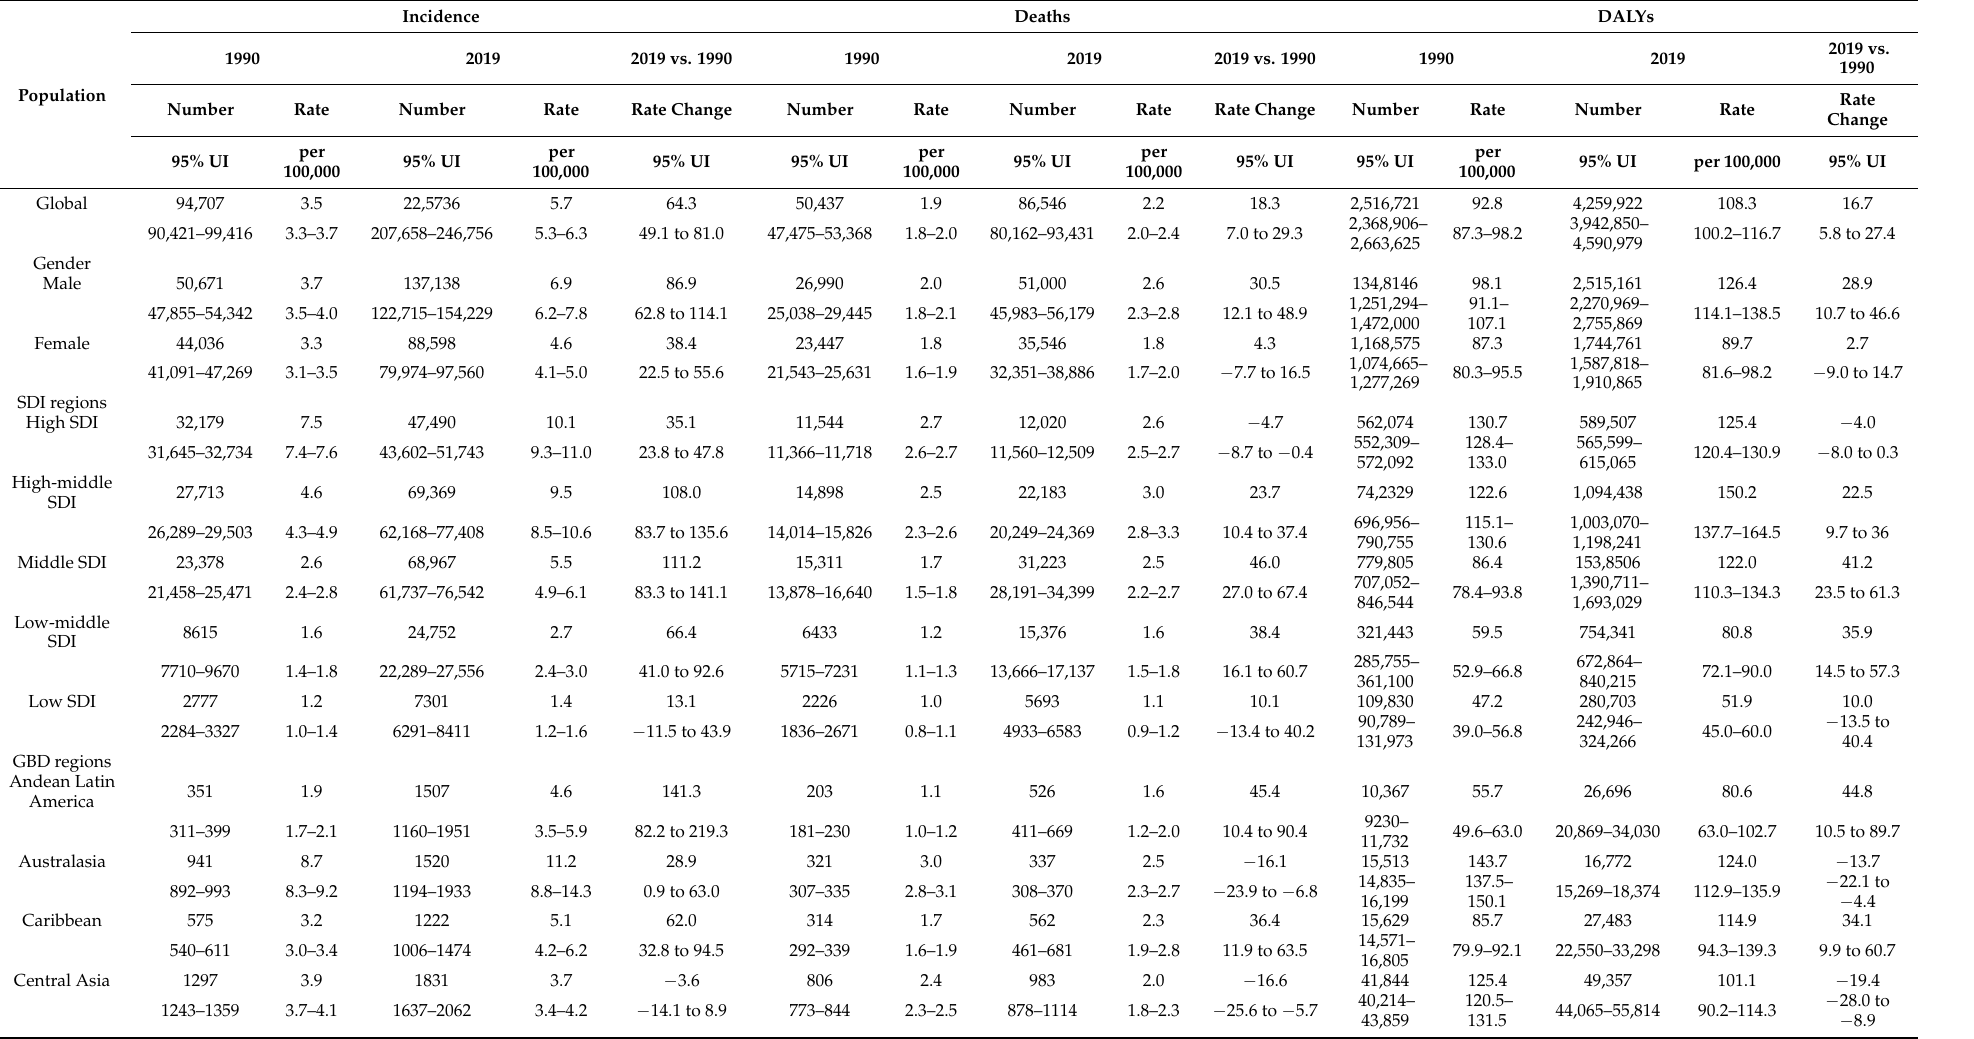
Table 1. Incidence, deaths, and DALYs of early-onset colorectal cancer between 1990 and